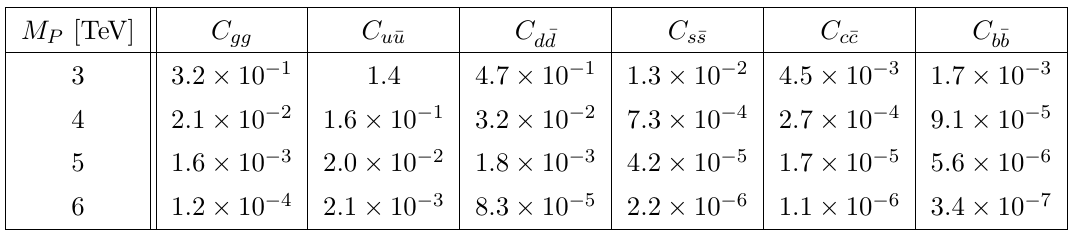
Table 1 . The C i coefficients defined in eq. (4.2), evaluated using the PDFs MSTW2008NLO [18], √ for s = 13 TeV and for relevant values of the parent mass M P